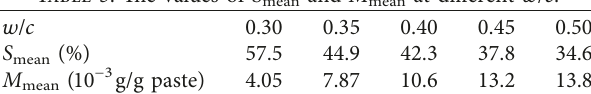
Table 5: The values of S